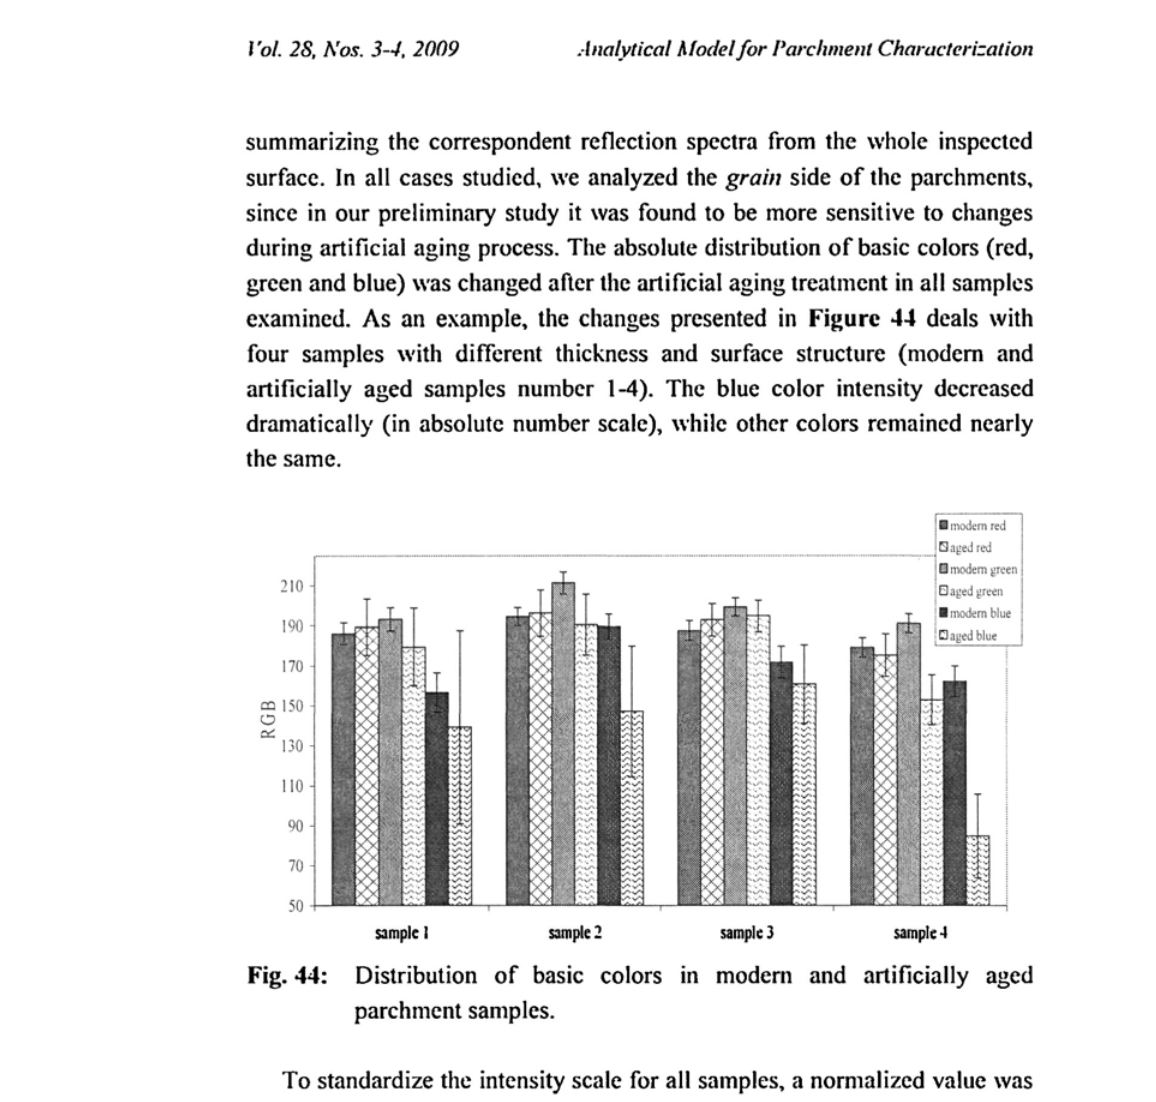
Fig. 44: Distribution of basic colors in modern and artificially aged parchment